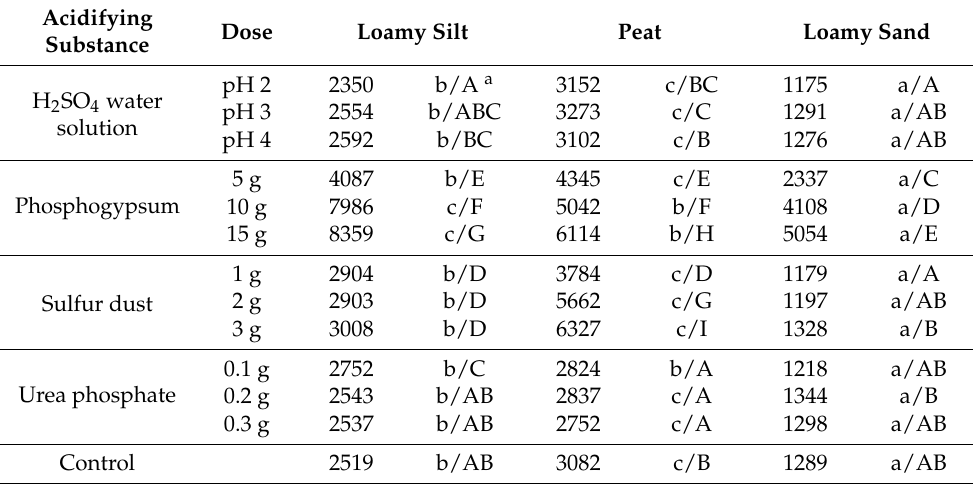
Table 7. Effects of acidifying substances after 12 months on the content of available calcium in loamy silt, peat and loamy sand